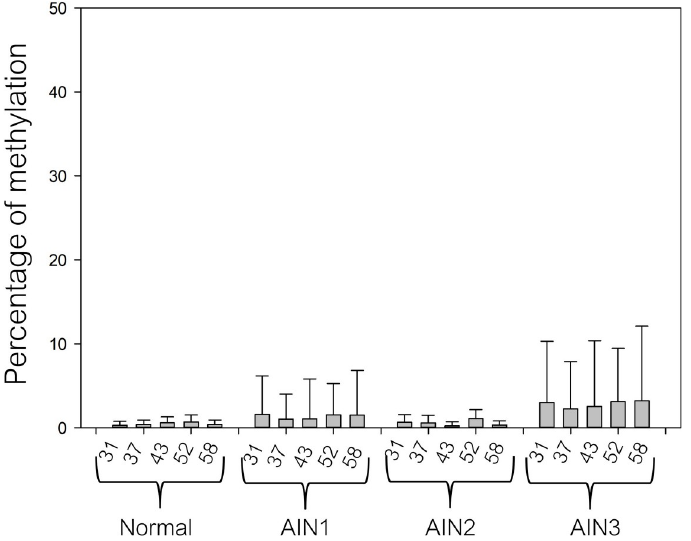
Fig 2. Methylation percentage of the early promoter in anal samples stratified by histology as normal, AIN1, AIN2 and AIN3. Error bars in the bar graph represent the mean with standard deviation (SD). The Kruskal–Wallis test was used to compare the differences among the groups. There were no statistically significant differences among the groups (P > 0.05).